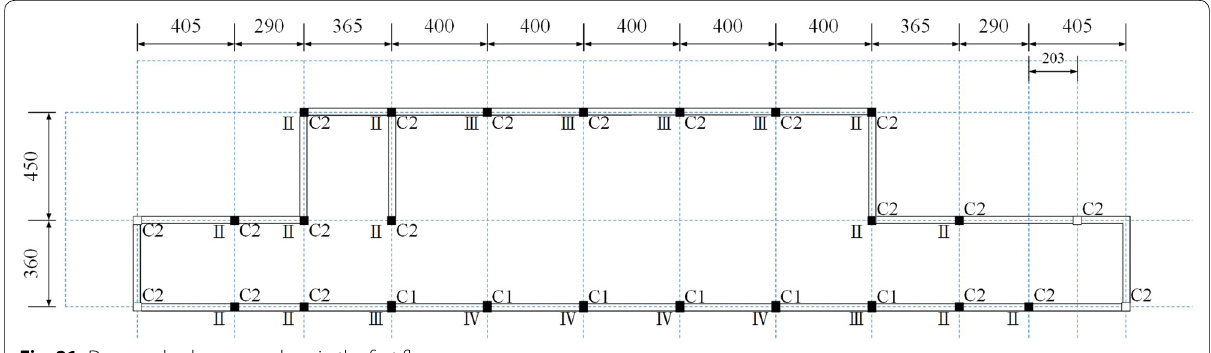
Fig. 21 Damaged column members in the first floor.